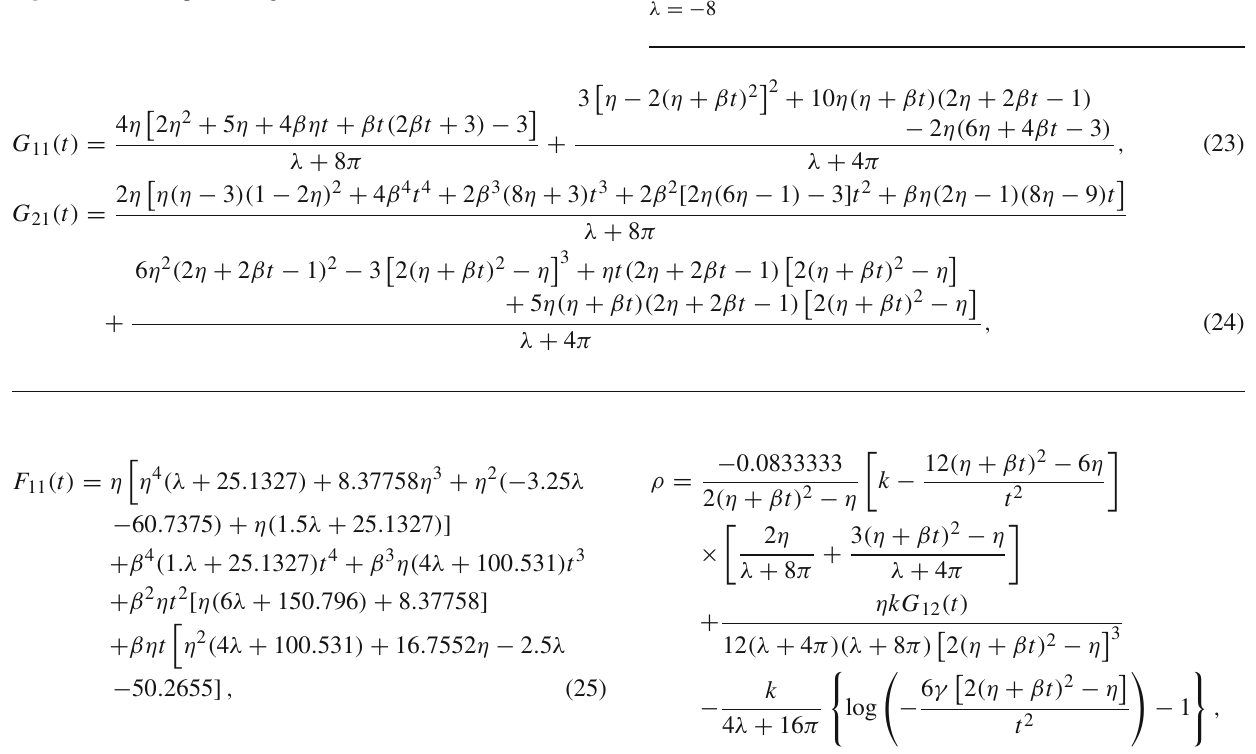
Fig. 5 Variation of pressure against z with α = 0 . 2, μ = − 1, λ = − 8 Fig. 6 VariationofEoSparameteragainsttimewith α = 0 . 2, μ = − 1, λ = −